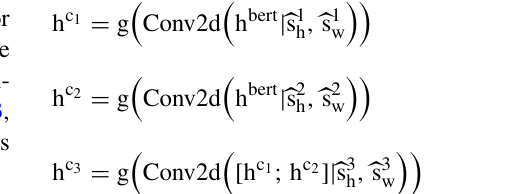
Conv2d-1, 2, 3, 4, and 5. The symbol “ ⊕ ” denotes the con- catenation of the vectors in Fig. 3. The output representations of the convolution operations are defined by formula (2)